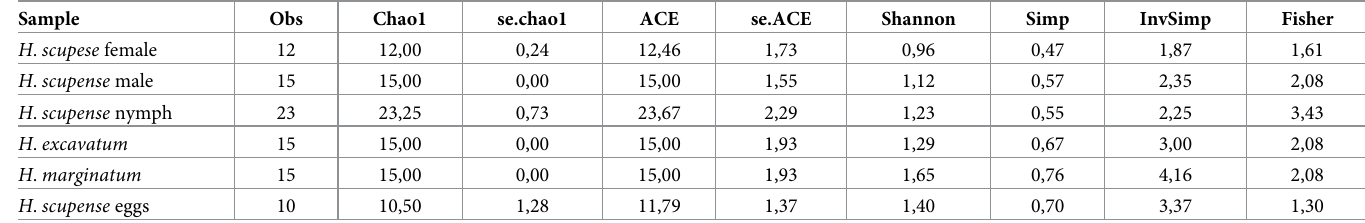
Table 3. Alpha diversity